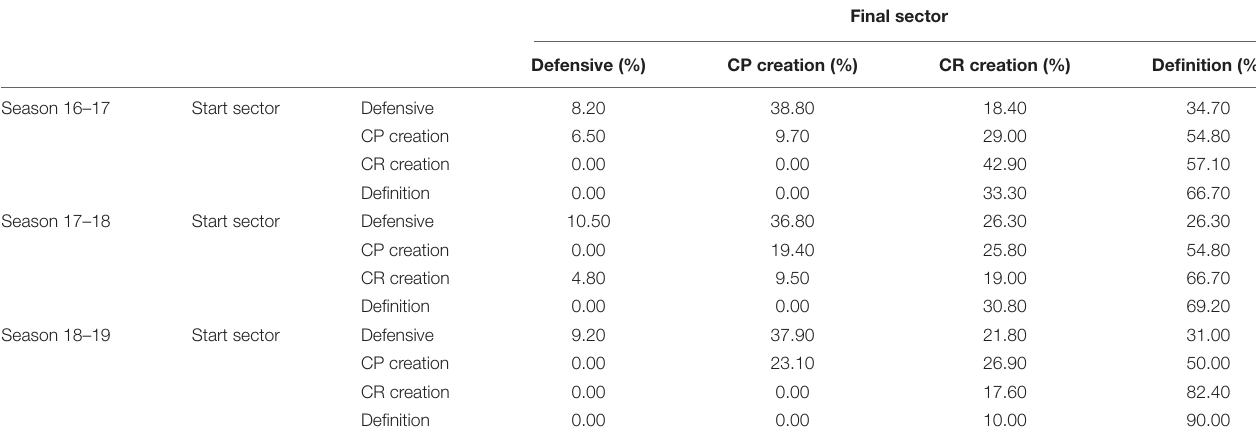
TABLE 4 | Contingency table: Season * Start Sector * Final Sector.